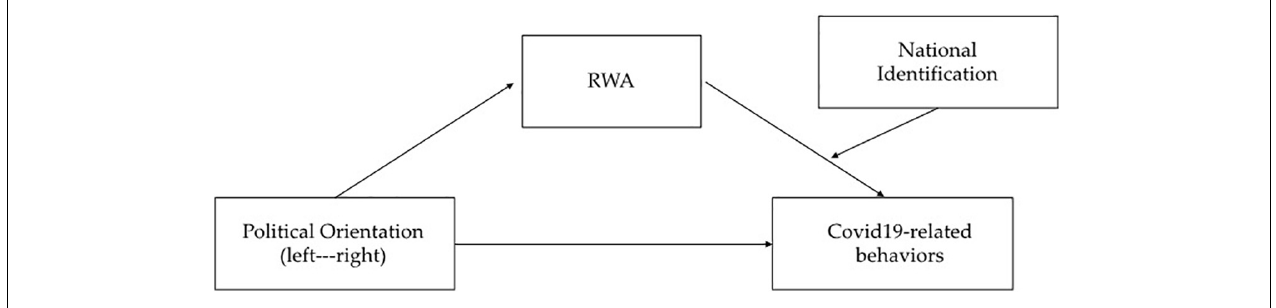
FIGURE 1 | Conceptual representation of the moderated mediation